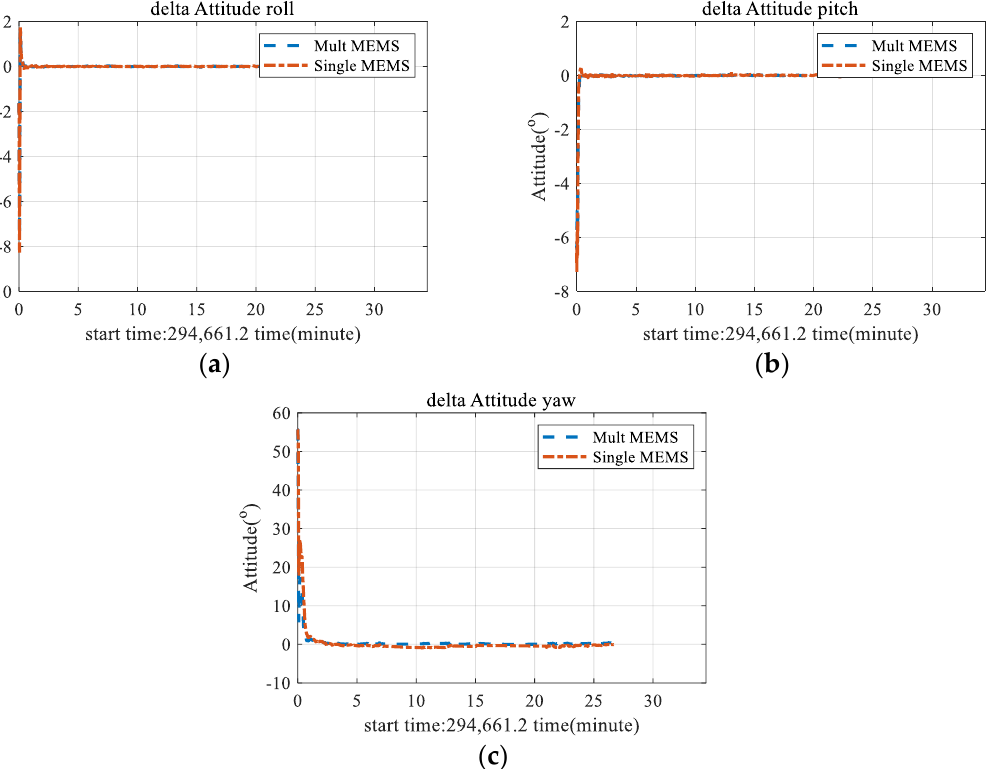
Figure 12. Comparison of attitude deviation under two models. ( a ) Deviation of roll. ( b ) Deviation of pitch. ( c ) Deviation of yaw.